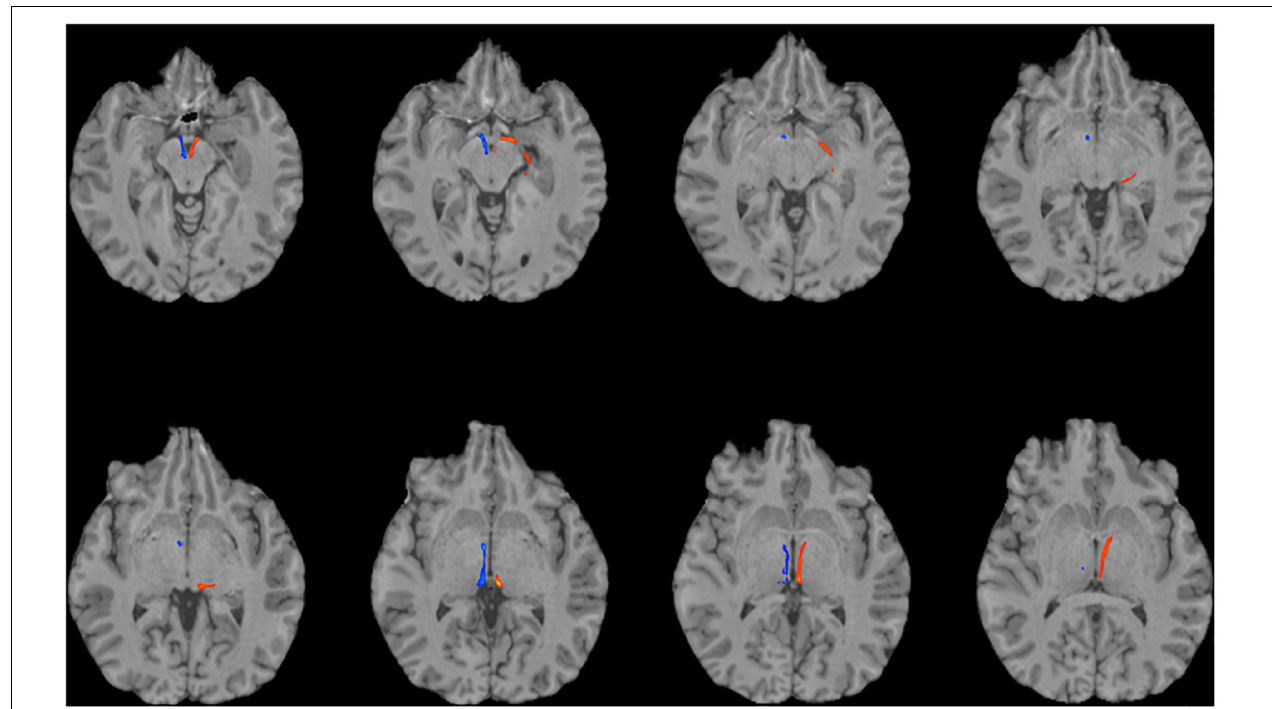
FIGURE 3 | Using multi-shell “clinical grade” dMRI data to reconstruct the afferent and efferent tracts of the LHb. Axial T1 MR images with superimposed streamline density maps of LHb fiber tracts are shown for a representative subject. Left hemisphere streamlines are colored in red and right hemisphere streamlines are colored in